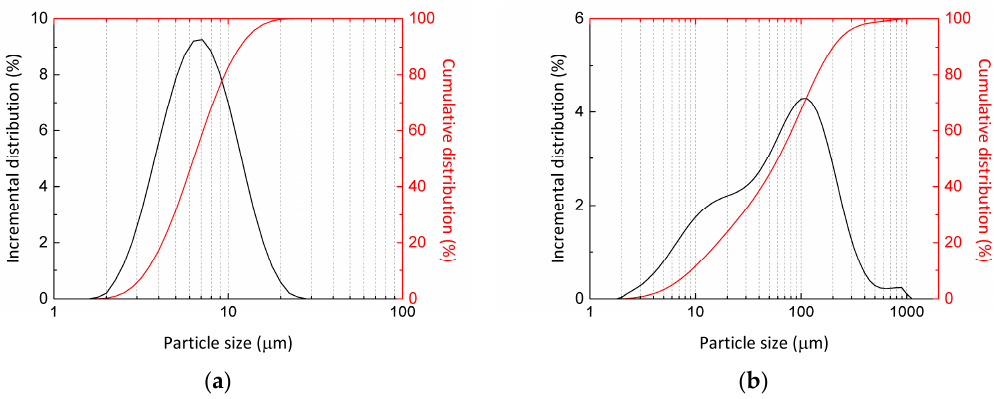
Figure 1. Particle size distribution of metakaolin Mefisto K05 ( a ) and low-calcium fly ash ( b ).